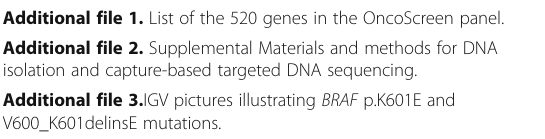
Additional file 2. Supplemental Materials and methods for DNA isolation and capture-based targeted DNA sequencing.